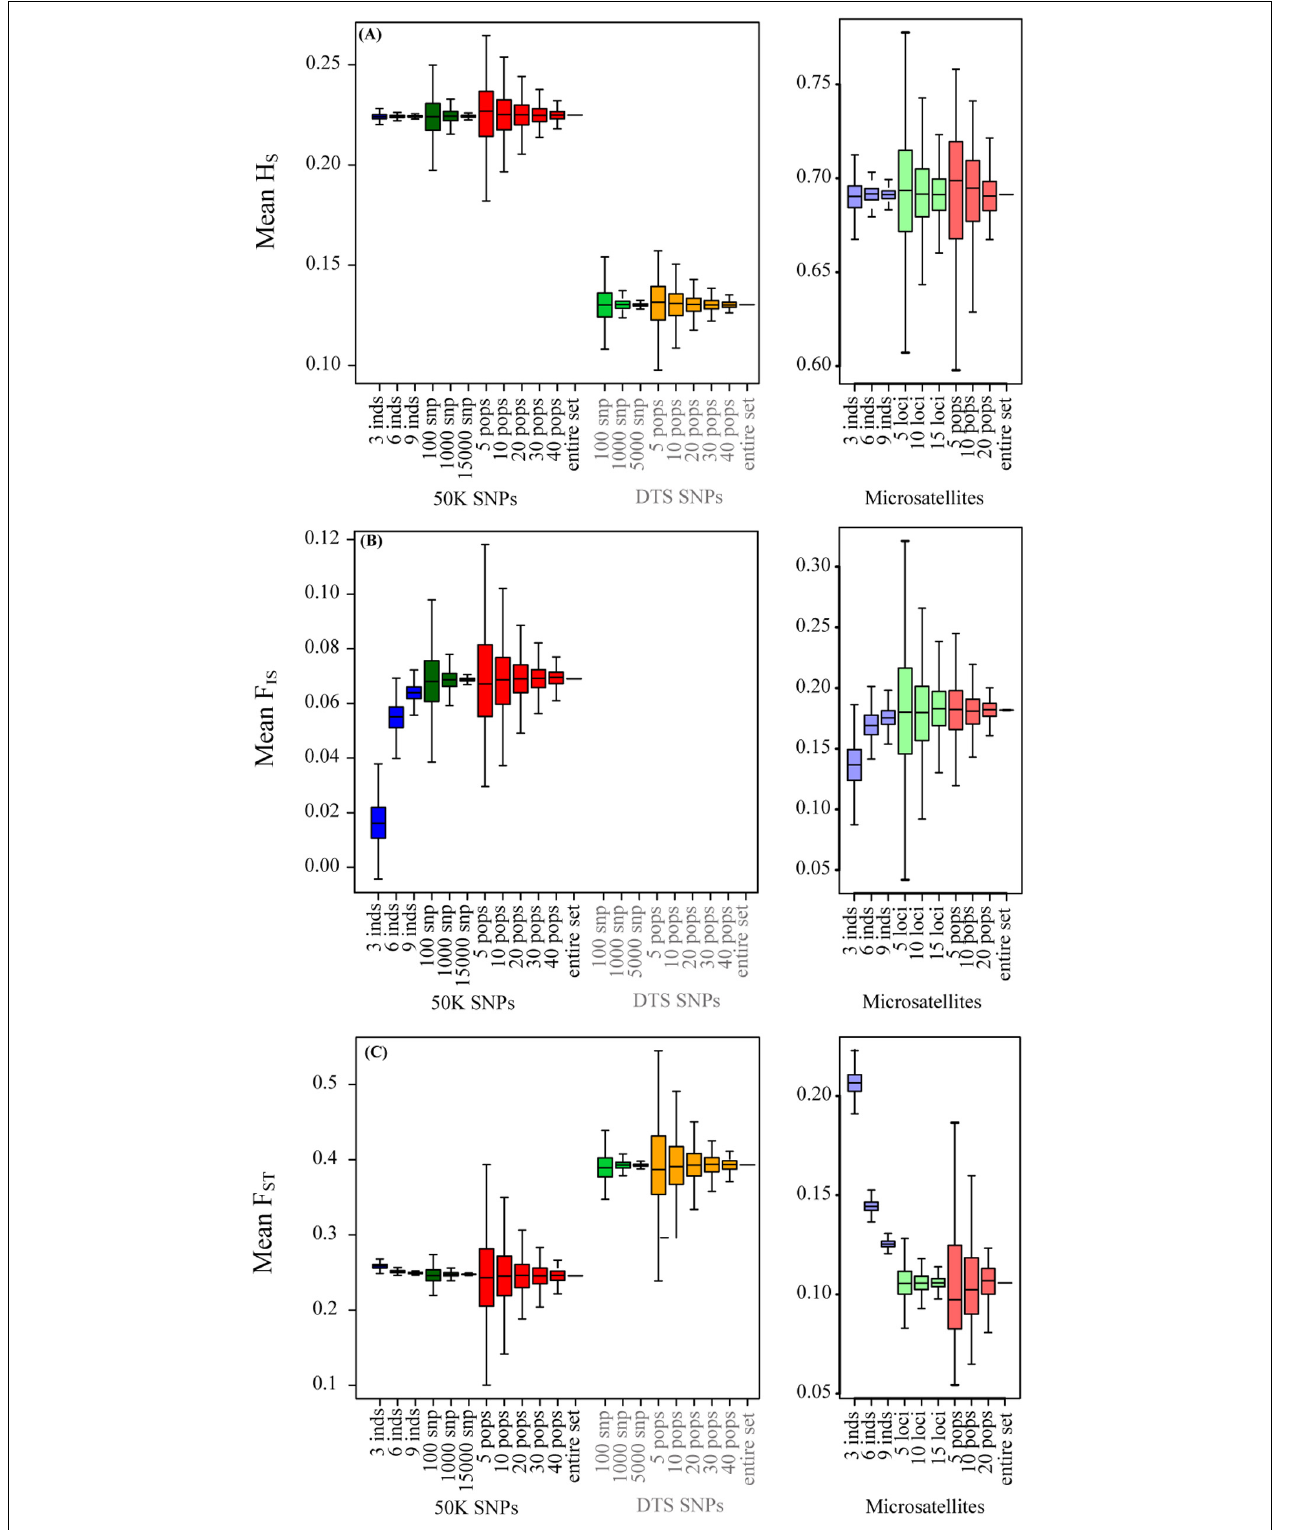
FIGURE 1 | The effect of sampling designs on the estimation of summary statistics for genomic (left panels) and microsatellite (right panels) datasets: (A) H S ; (B) F IS ; (C) F ST . Boxplots show the distribution of mean summaries estimated for 1,000 replicate simulations varying the number of individuals, number of SNPs, and number of populations sampled. F IS was not possible to obtain for the DTS dataset because it is based on pooled data.